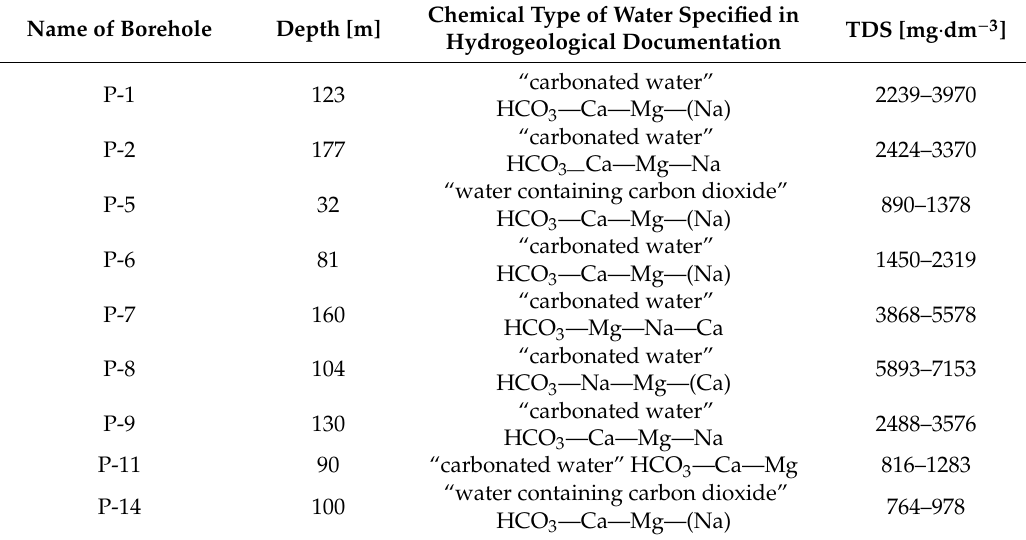
Table 1. Basic parameters of the analyzed